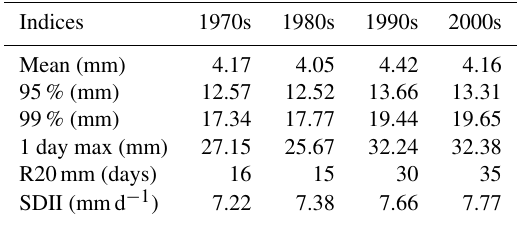
Table 6. Summary of the UBNRB’s precipitation indices at decadal time series.